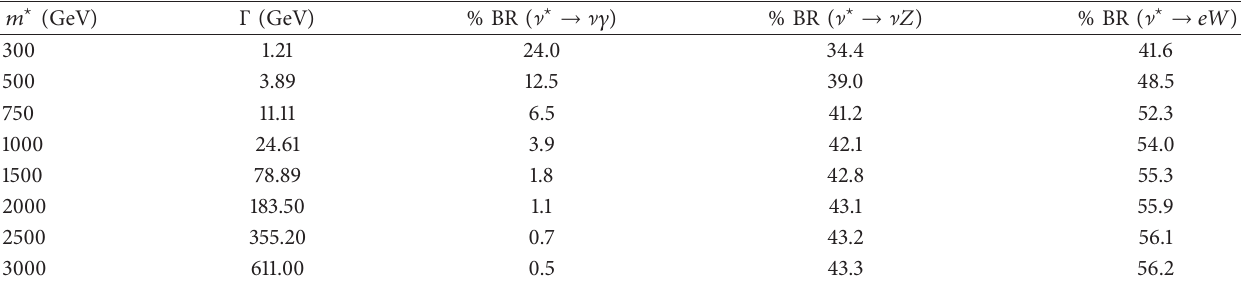
Figure 3: Cross-sections for the excited neutrino production with Λ = 𝑚 ⋆ and 𝑓 = −𝑓 󸀠 for spin-1/2 ones and 𝑐 𝑖𝑉 = 𝑐 𝑖𝐴 = 0.5 (𝑖 = 1,2) for spin-3/2 ones at 𝑒𝑝 collider at √ 𝑠 = 1.3 TeV and √𝑠 = 1.98 TeV. Table 2: Branching ratios and total decay width of excited spin-3/2 neutrinos with 𝐽 1 . Here it is taken as 𝑐 1𝑉 = 𝑐 1𝐴 = 0.5 and Λ = 𝑚 ⋆